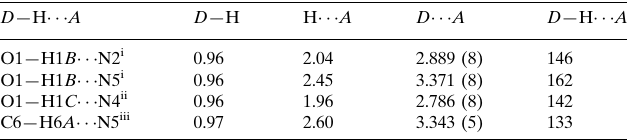
Hydrogen-bond geometry (A˚ , (cid:1)